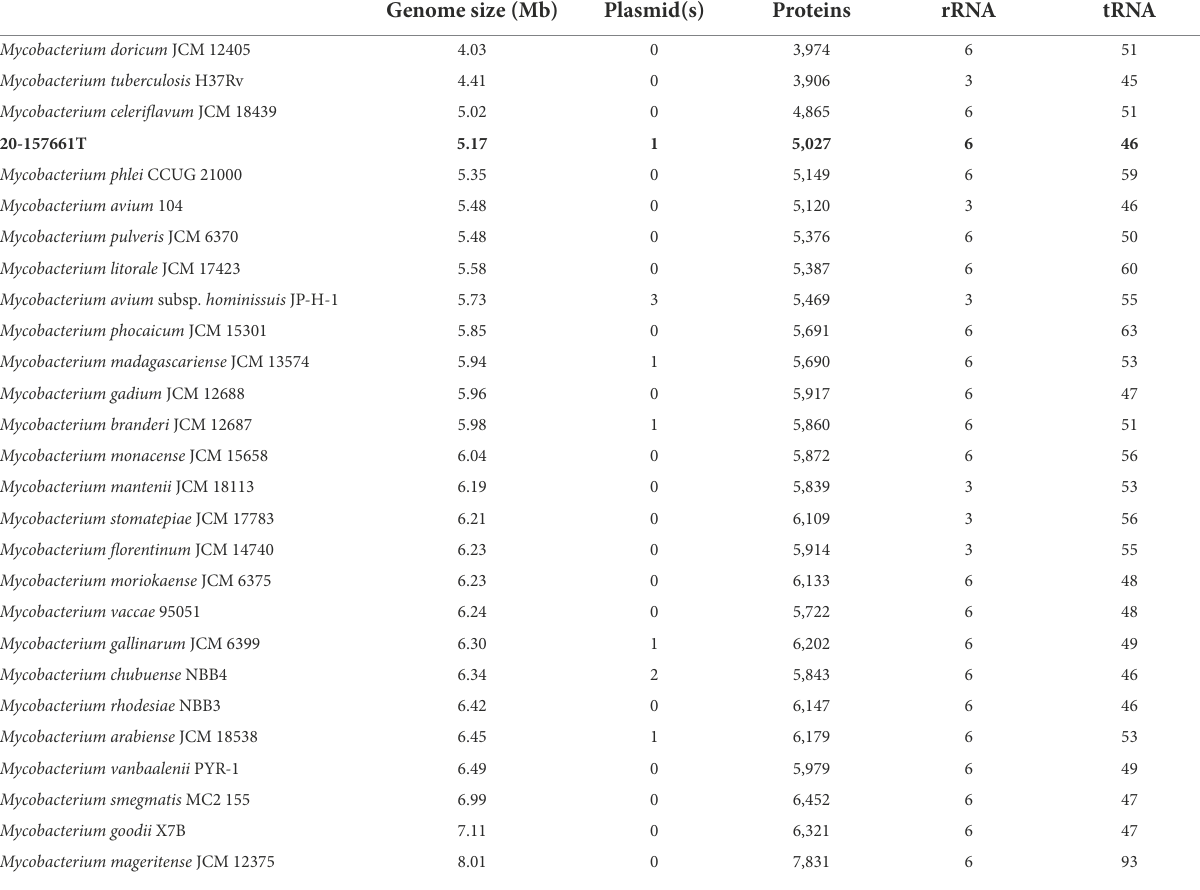
TABLE 2 Genome sizes, plasmid numbers, predicted coding proteins, rRNAs and tRNAs. Genome size